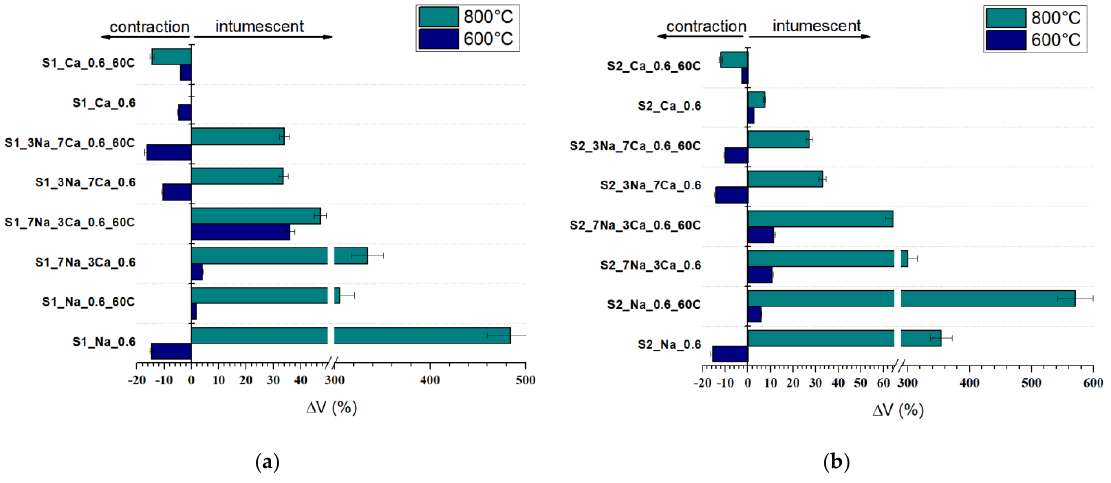
Figure 11. Volume change vs. temperature for ( a ) G-AAIPS based on S1 glass powder and ( b ) G- AAIPS based on S2 glass powder.